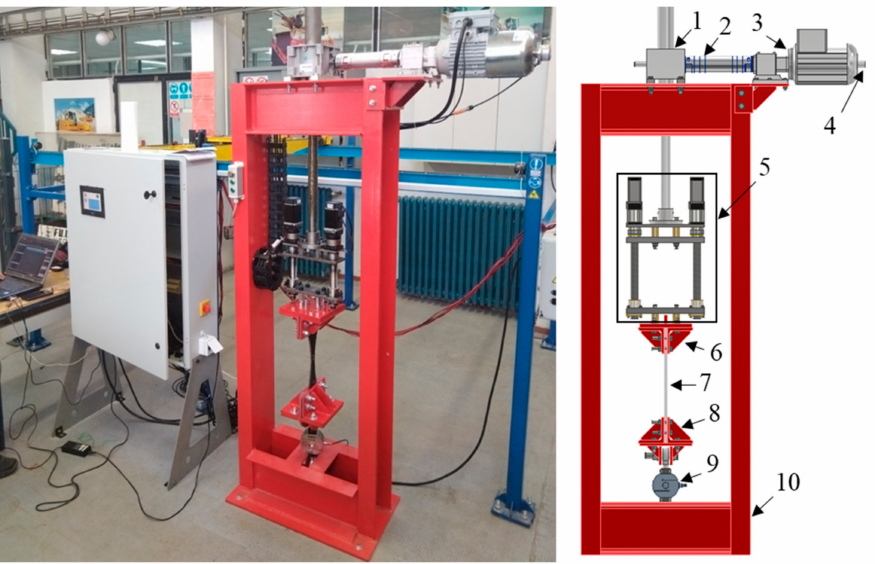
Figure 3. Device for testing conveyor belts UZITT MKM 5000 during the experiment: worm gear screw jack (1), connecting shaft (2), helical geared electric motor (3), rotary encoder (4), fatigue testing module (5), upper jaw (6), belt specimen (7), lower jaw (8), force cell (9) and the supporting frame